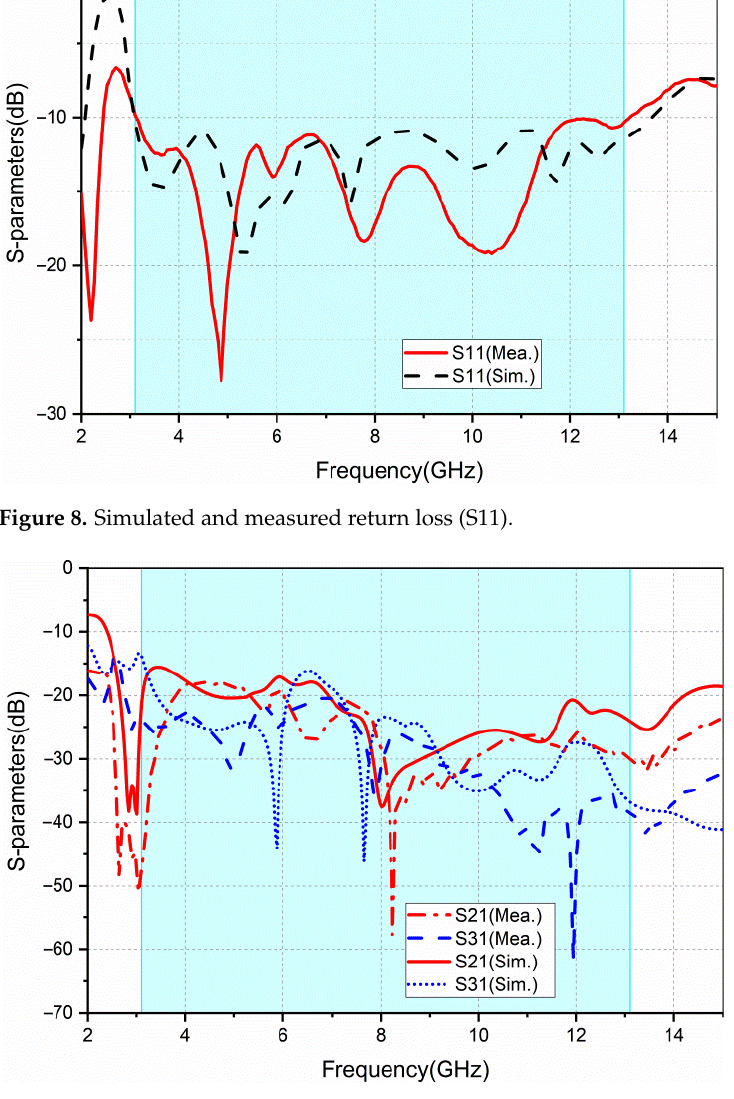
Figure 9. Simulated and measured isolation (S21, S31).